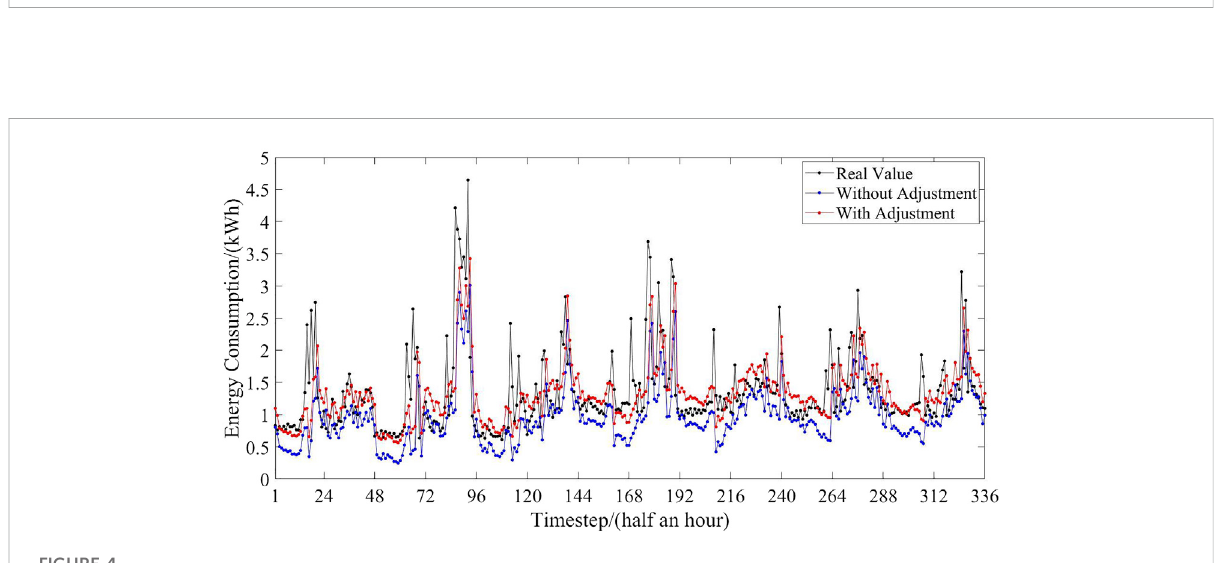
FIGURE 4 Load pro fi les of the proposed and benchmark methods (Resident